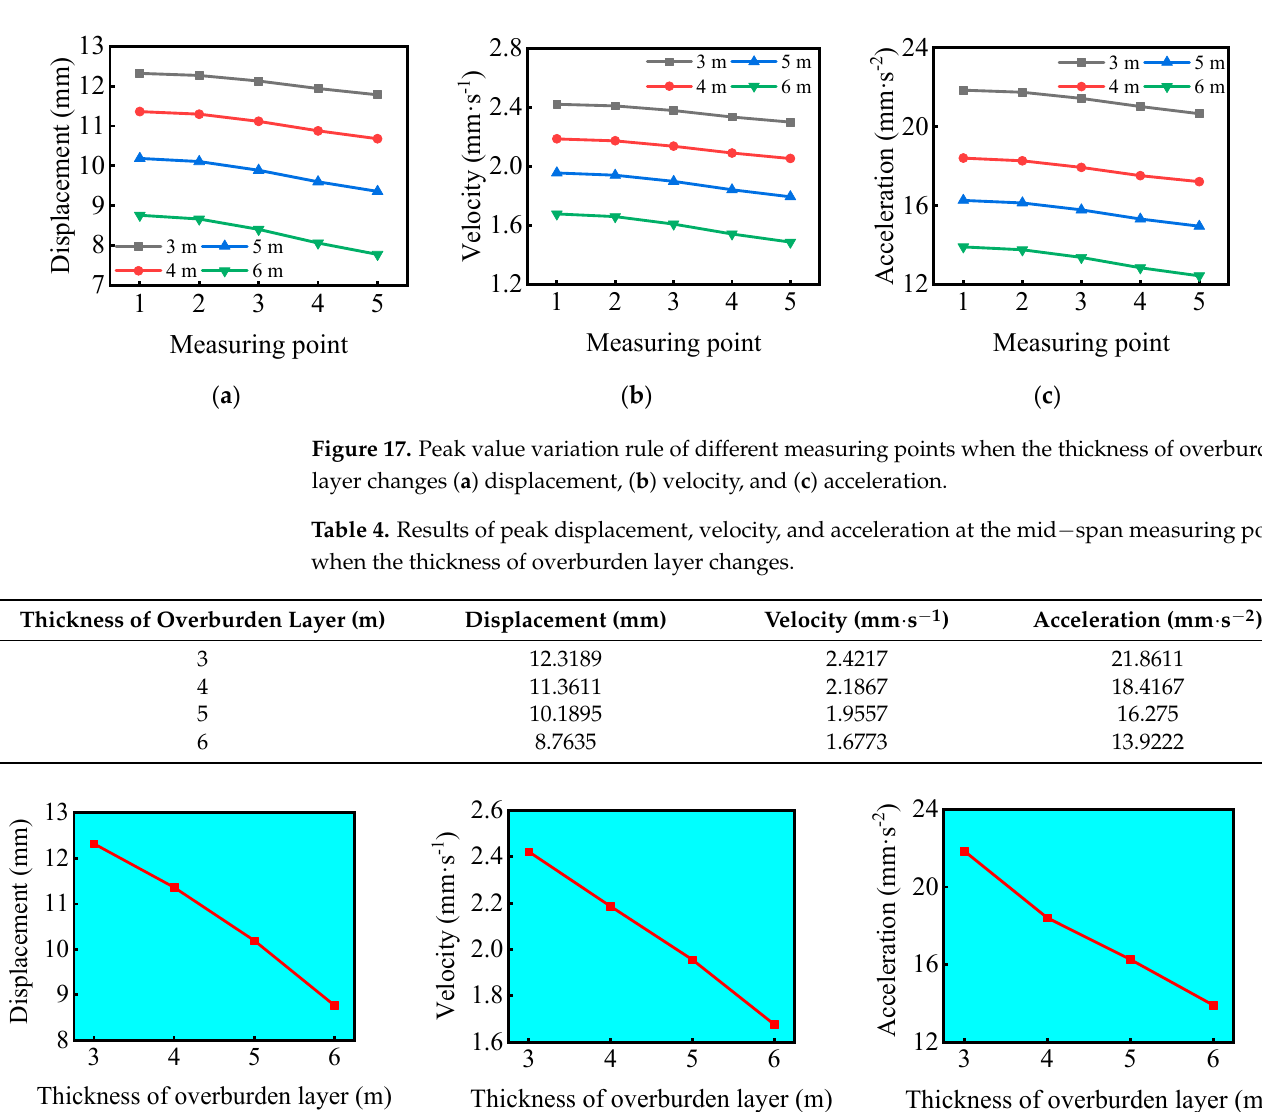
Figure 18. The law of mid − span peak value changing with thickness of overburden layer ( a ) dis- placement, ( b ) velocity, and ( c ) acceleration.